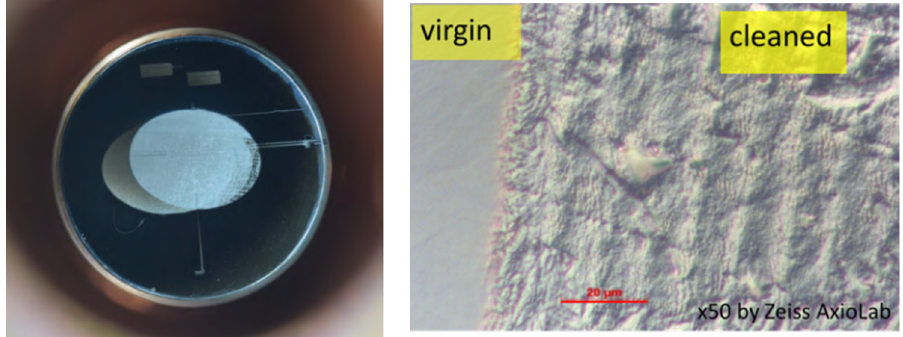
Figure 4. Photograph of Mg photocathode Mg#214 after second laser cleaning ( left ) and surface structure changes after cleaning (optical microscope image, ( right )) [29].